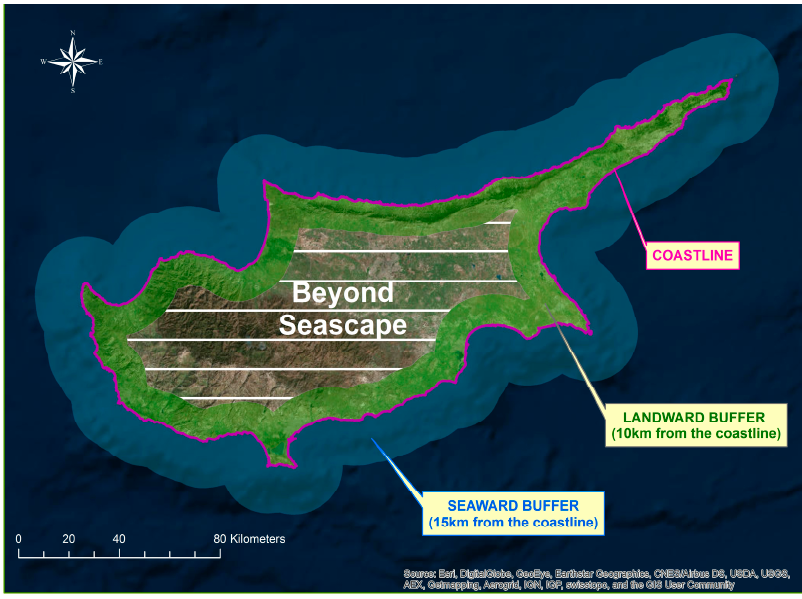
Figure 1. Zones in island character assessment in Cyprus.